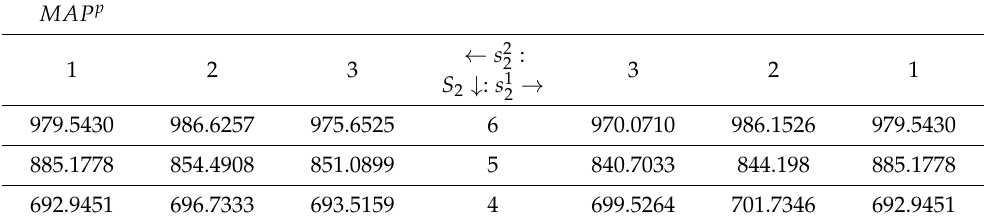
= 1) with MAP n in the cost incurred , S 2 ) (fix s 1 2 2